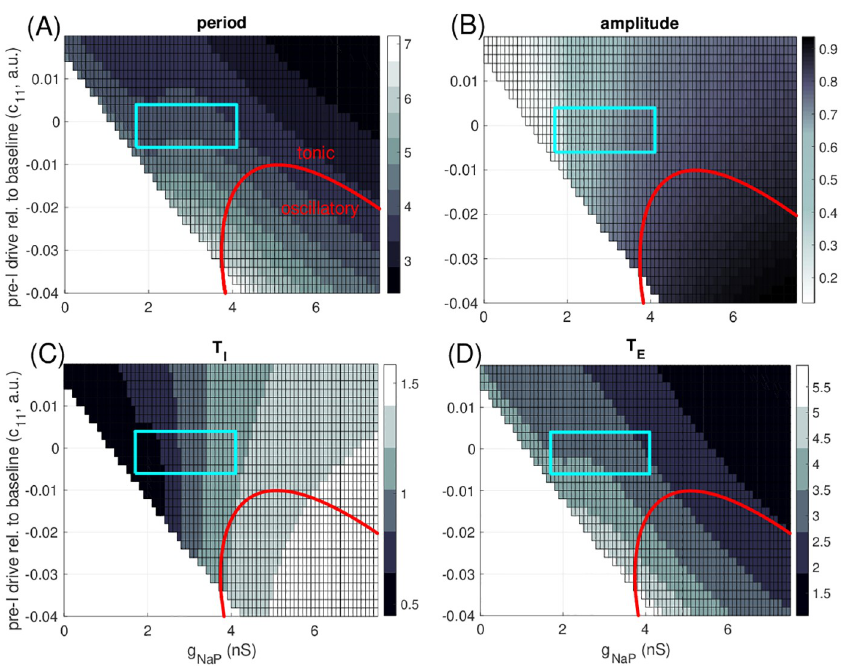
Fig 5. Parameter-dependence of model output. In all cases, g NaP refers to the persistent sodium conductance for the from the Methods section). (A) Grey scale in boxes codes period of full rhythm, with longest pre-I unit (i.e., g NaP , exc period given by palest shades (color bar, periods in seconds). For parameter values in the unboxed white region, the network is not rhythmic. For parameter values below the red curve, the pre-I neuron is intrinsically oscillatory. (B) Grey scale codes amplitudes, with largest amplitude given by darkest shades (color bar, amplitudes measured as maximum minus minimum of pre-I output, f ( V 1 )). Red curve as in upper left. (C) Grey-coded inspiratory phase duration (seconds), measured as time between increased and subsequent decreases of V 1 through a threshold of -35 mV. (D) Grey-coded expiratory phase duration (seconds), measured as the period minus the inspiratory phase duration. The blue boxed regions are explained in the